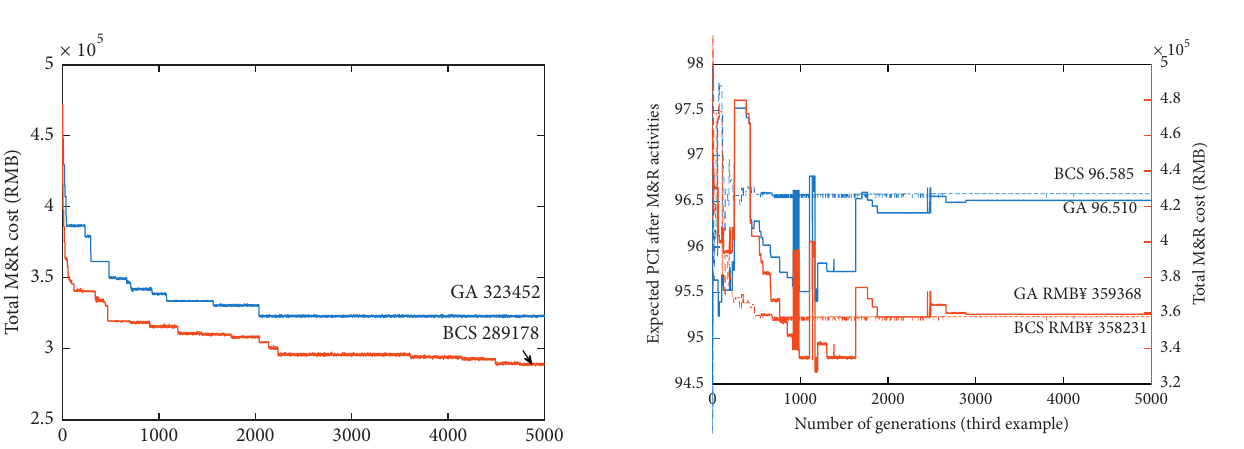
Figure 7: Convergence curve of biobjective